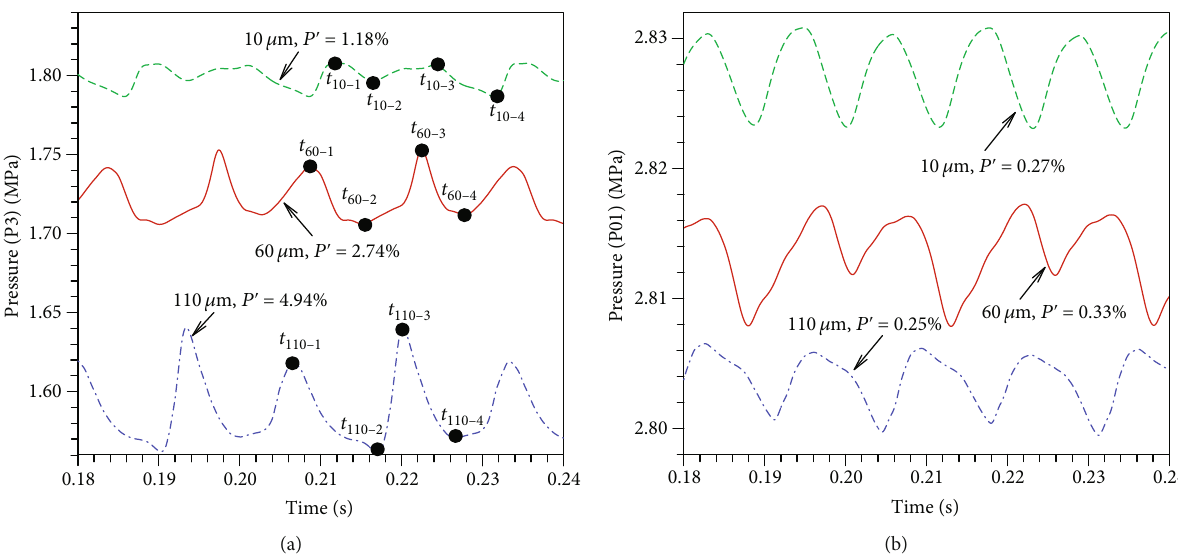
Figure 14: Time histories of the pressure oscillations for di ff erent initial LOX particle diameters: (a) combustor (P3); (b) gas manifold (P01).